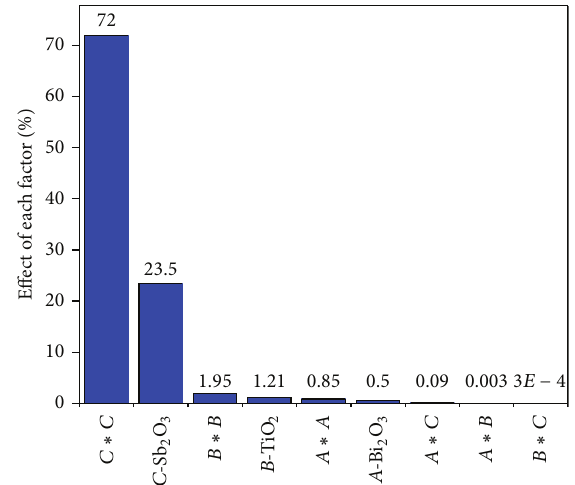
Figure 2: Pareto chart showing the importance of the additives and their interactions on